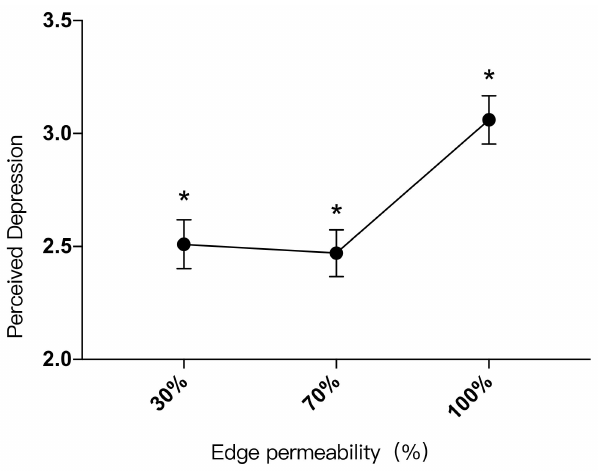
Figure 10. Impacts of different edge permeability levels on perceived depression, *: p <